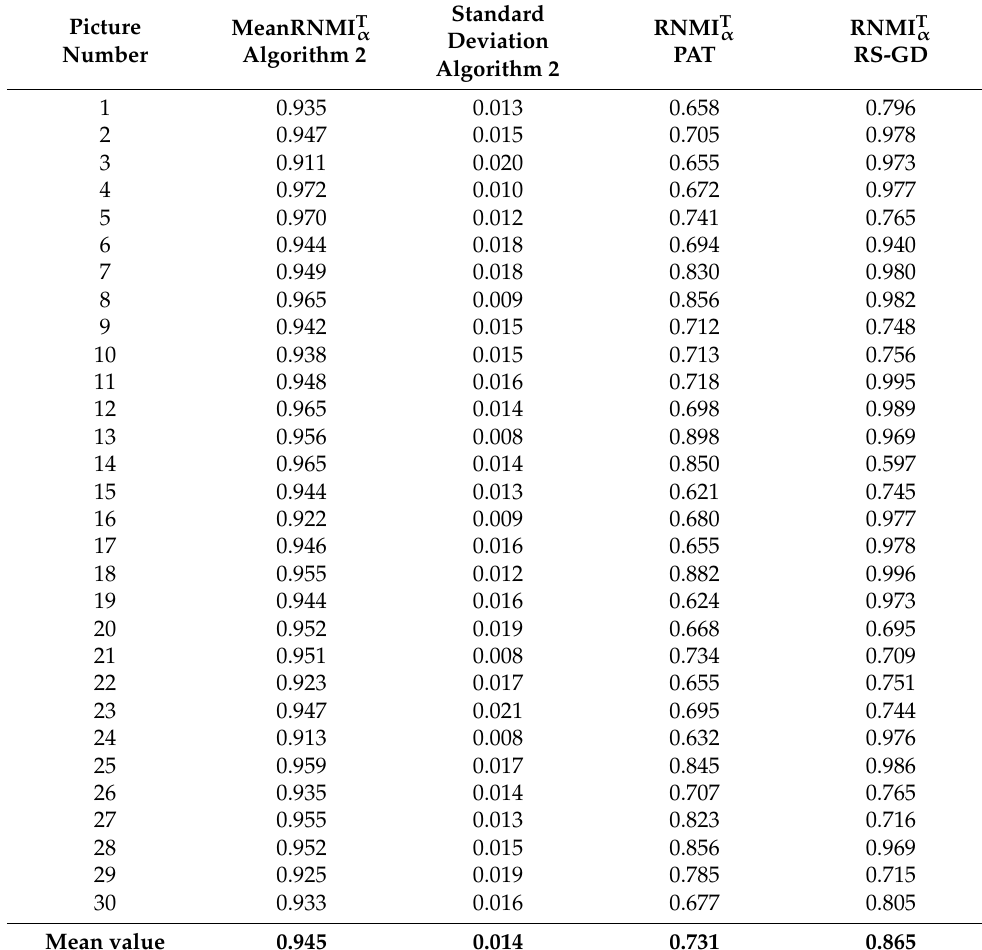
Table 4. The RNMI T α values—Algorithm 2, PAT and